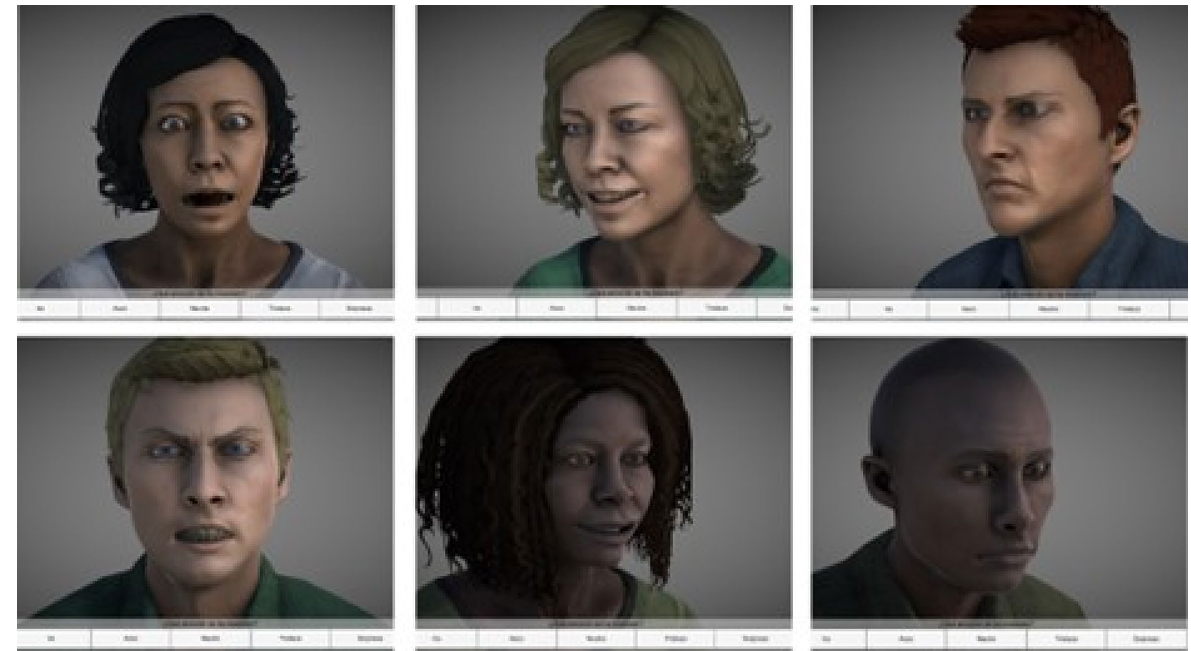
Figure 1. A few DVF samples created by the authors using Unity version 2020.2.2f1 (https:// unity.